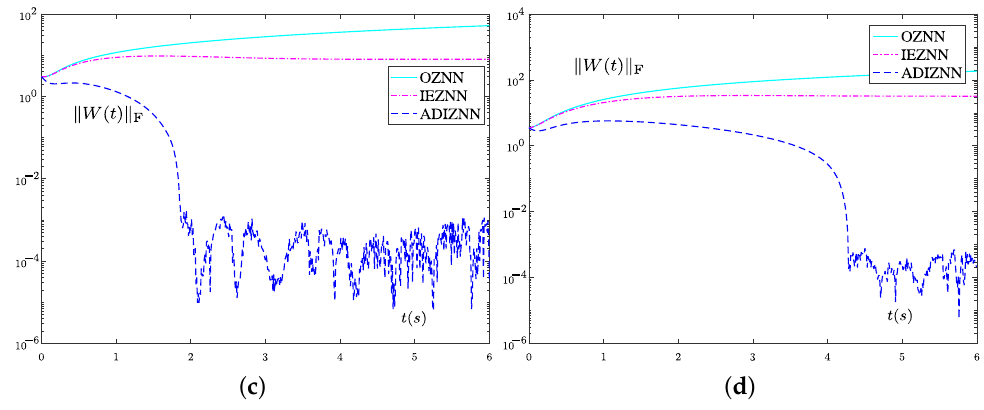
Figure 5. Error norms (cid:107) W ( t ) (cid:107) of OZNN (9), IEZNN (12) and ADIZNN (19) for the DSE with (36) in F different noise environments. ( a ) z i ( t ) = 0. ( b ) z i ( t ) = t /4 + 4. ( c ) z i ( t ) = 4 t + 4. ( d ) z i ( t ) = 16 t +